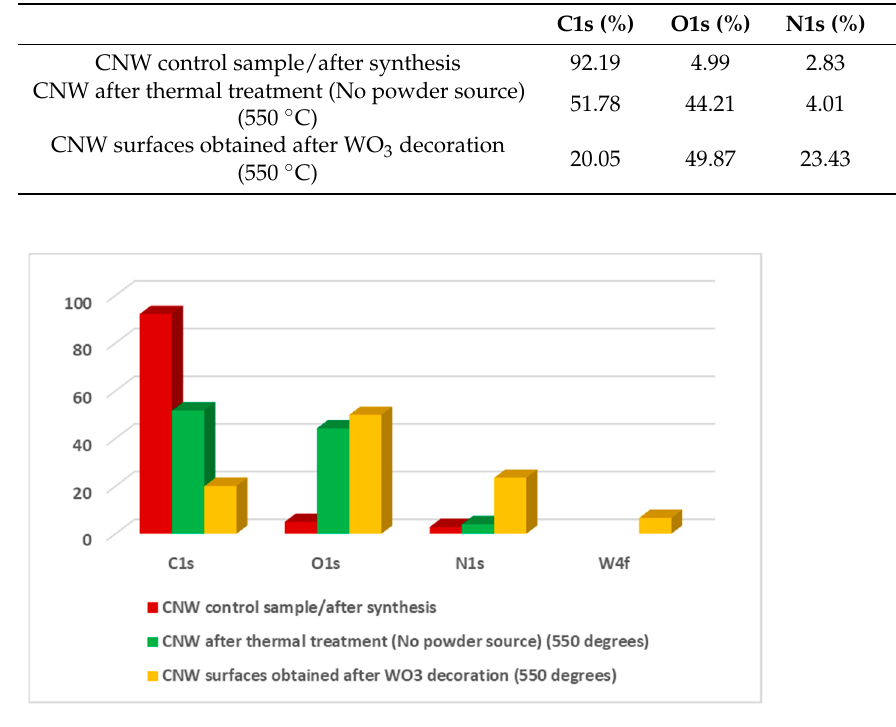
( b ) Figure 16. XPS deconvolution results for hybrid nanostructures obtained in plasma on condition in ( a ) W4f region ( b ) N1s region.